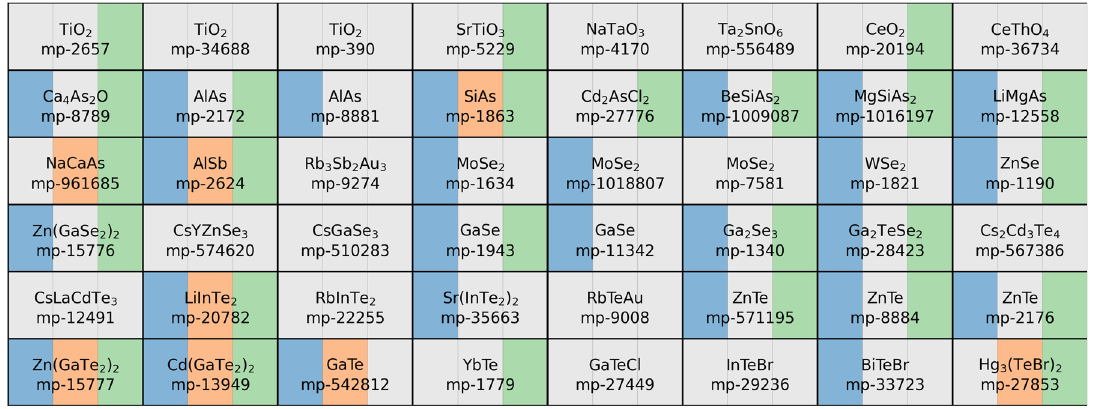
and α aniso in the int int